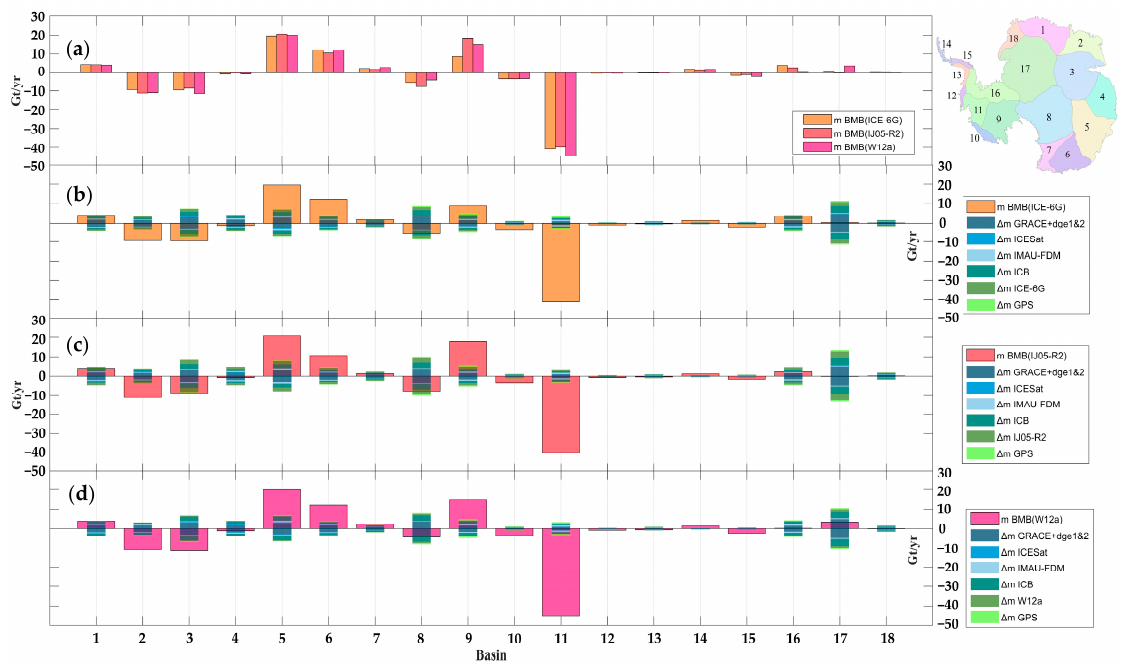
Figure 9. ( a ) Comparison of regional BMB rates in 18 drainage basins and ( b – d ) error contributions of each input datasets. Figure 10 displays spatial distributions of BMB rates and associated standard devia- tions. Red colours in Figure 10a–c are basal mass increases regions with positive BMB rates, while blue colours are basal mass decrease regions with negative BMB rates; shad- ows represent unsignificant regions where the BMB rates are lower than the associated Std. As shown in Figure 10a–c, three BMB results show similar spatial distributions with the obvious basal mass changes occurring mainly in WAIS, marginal regions of EAIS, and Wilkes Land. The Std of the three BMB results (Figure 10d–f) also show identical spatial